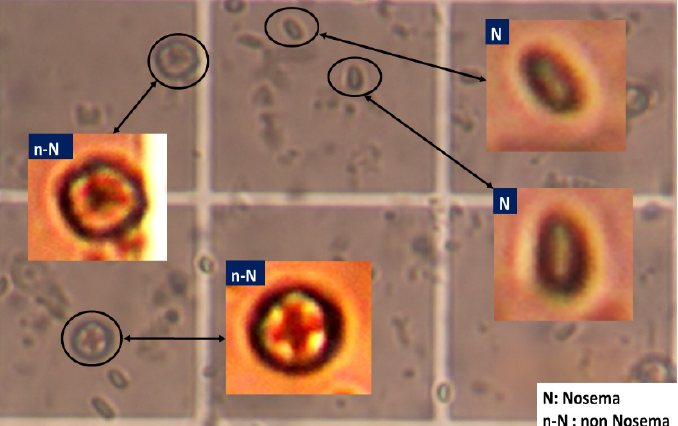
Figure 1. Example of extraction of Nosema cells and other existing objects in a part of one micro- scopic image. image.